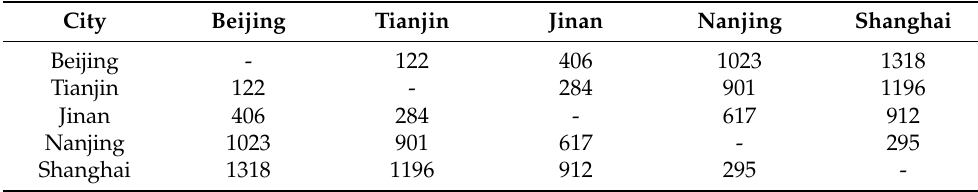
Table 1. The distance between major cities (km).